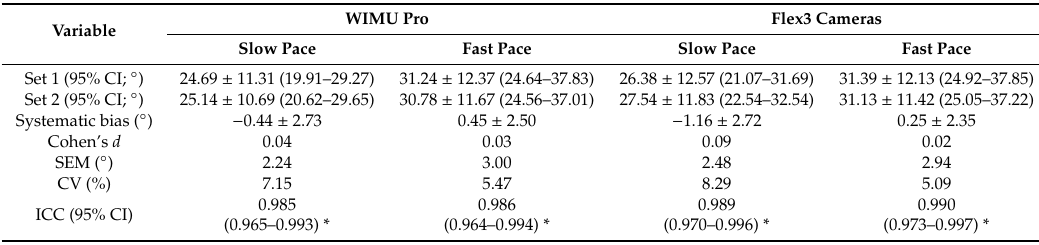
Table 2. Test–retest reliability of WIMU Pro and MOCAP system when used to monitor the range of motion during fast- and slow-paced IOCs.